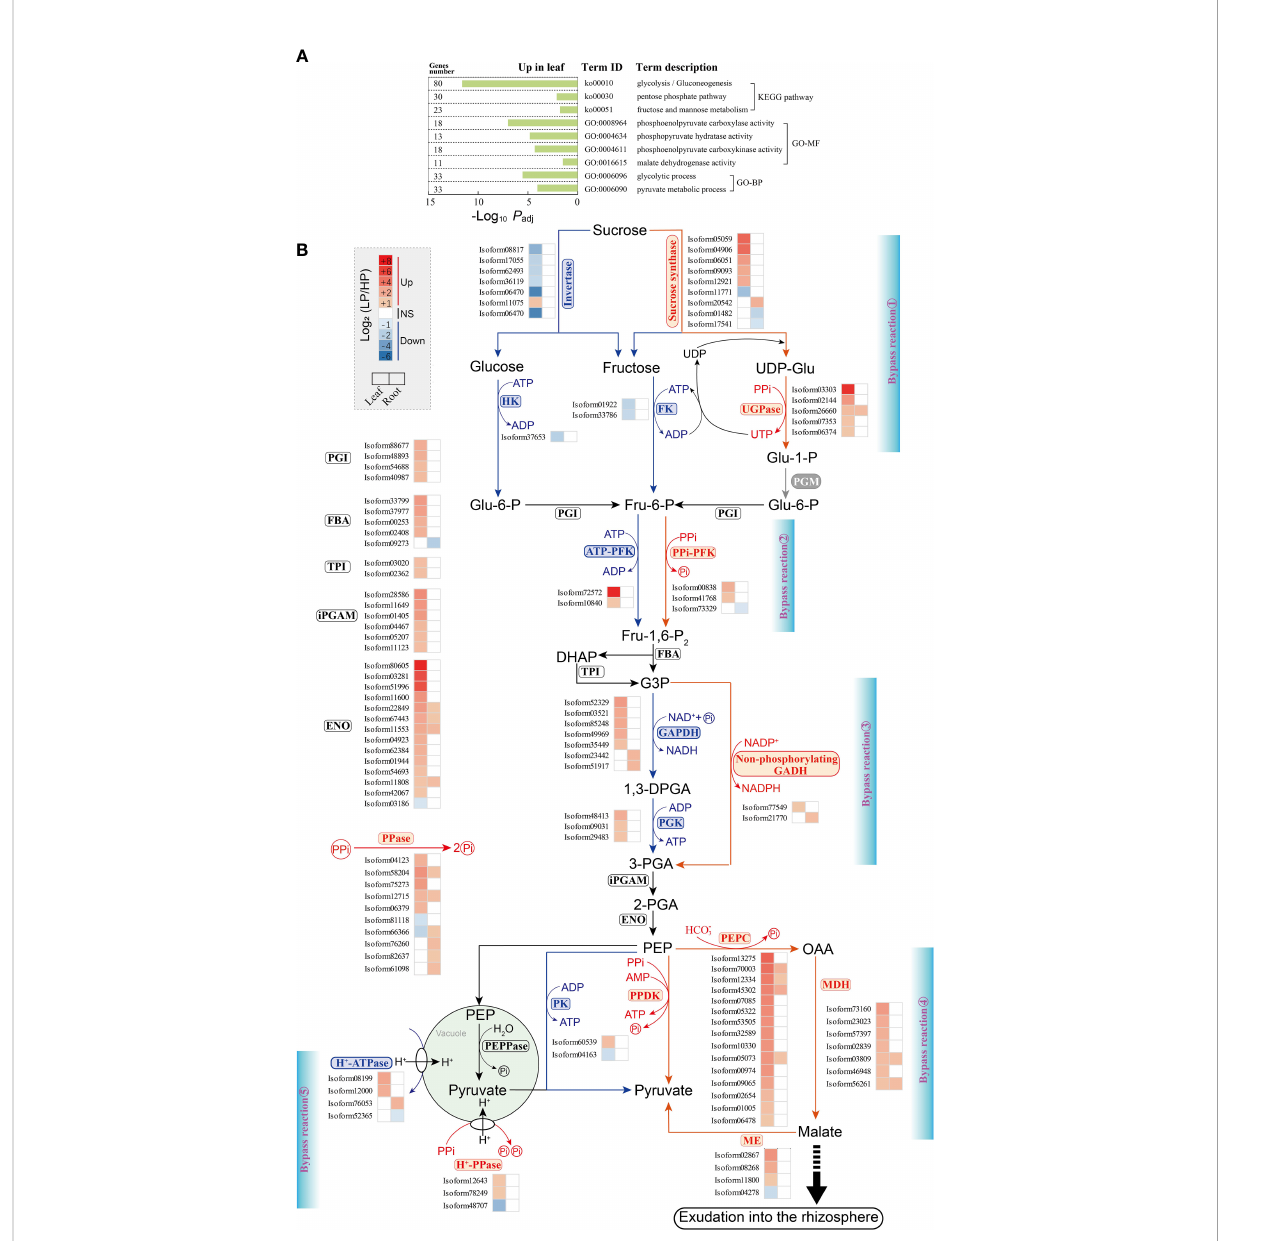
FIGURE 6 Changes in unigenes involved in glycolysis in elephant grass leaves and roots upon Pi deprivation. (A) The signi fi cantly enriched KEGG pathways and GO terms associated with DEGs of glycolysis metabolism. (B) DEGs associated with glycolysis metabolism are shown; color intensity corresponds to expression levels calculated using log 2 (LP/HP). The fi ve bypass reactions performed by Pi-independent or PPi-dependent enzymes, are marked in red. UGPase, UDP-glucose pyrophosphorylase; FK, fructokinase; HK, hexokinase; PPi-PFK, PPi-dependent 6- phosphofructokinase; ATP-PFK, ATP-dependent 6-phosphofructokinase; FBA, fructose-bisphosphate aldolase; TPI, triosephosphate isomerase; GAPDH, NAD-dependent glyceraldehyde-3-phosphate dehydrogenase; PGK, phosphoglycerate kinase; non-phosphorylating GADH, NADP- dependent glyceraldehyde-3-phosphate dehydrogenase; iPGAM, 2,3-bisphosphoglycerate-independent phosphoglycerate mutase; ENO, enolase; PK, pyruvate kinase; PPDK, pyruvate orthophosphate dikinase; PEPC, phosphoenolpyruvate carboxylase; MDH, malate dehydrogenase; ME, malic enzyme; PEPPase, phosphoenolpyruvate phosphatase; H + -ATPase, H + -adenosine triphosphatase; H + -PPase, H + -pyrophosphatase; PPase, inorganic